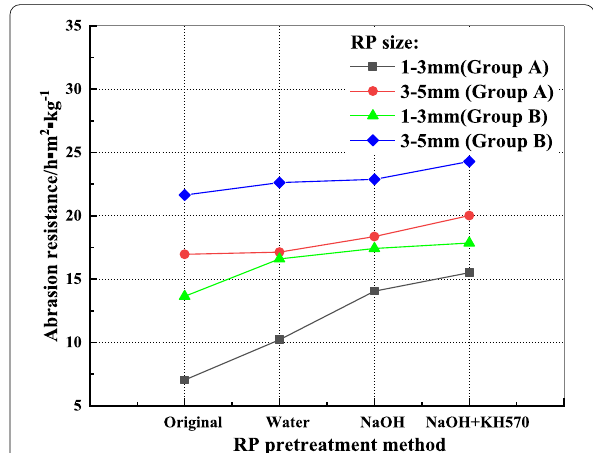
Fig. 16 Effect of different RP pretreatment methods on the abrasion resistance